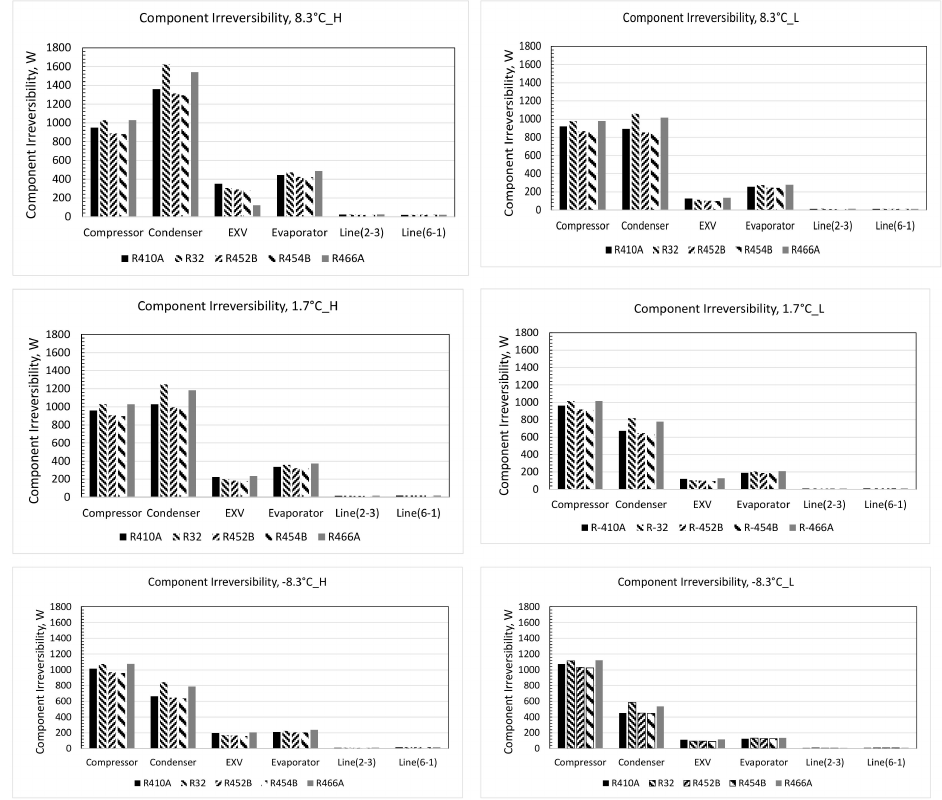
Figure 7. Irreversibility structure of heat pump components at ambient temperatures specified by the Air-Conditioning, Heating, and Refrigeration Institute (AHRI) 210 / 240 standard. Space heating temperature in all cases is at 21.1 ◦ C, as per the standard. Lines (6-1) and (2-3) refer to connecting lines from the evaporator